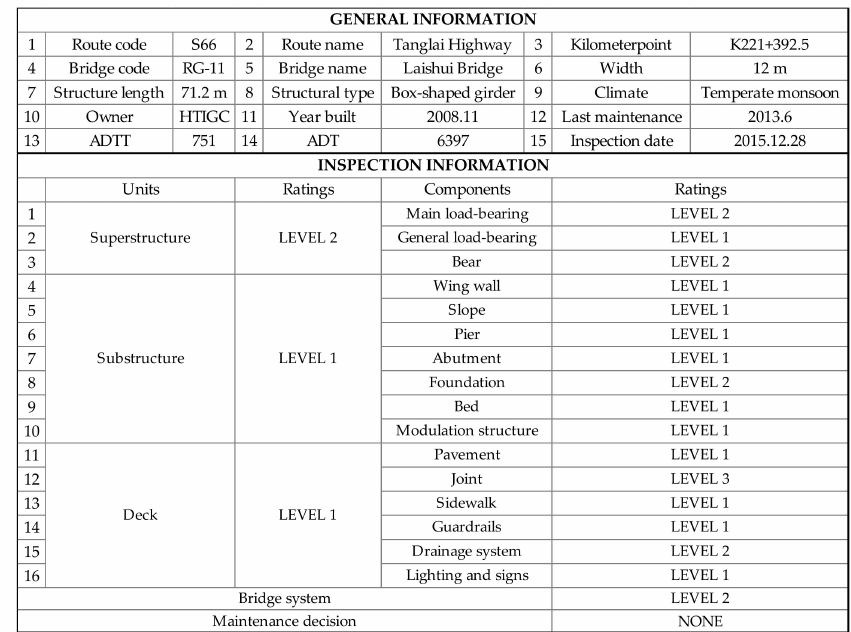
Figure 3. General information and inspection information extracted from inspection